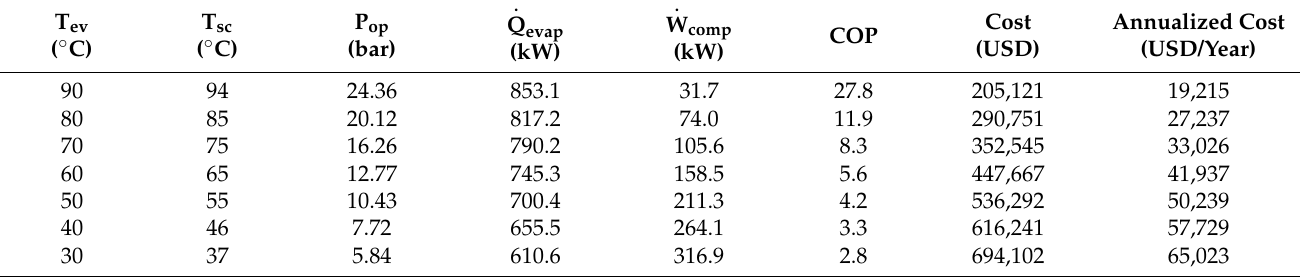
Table 1. Operating conditions for different evaporator temperatures and heat pump cost.